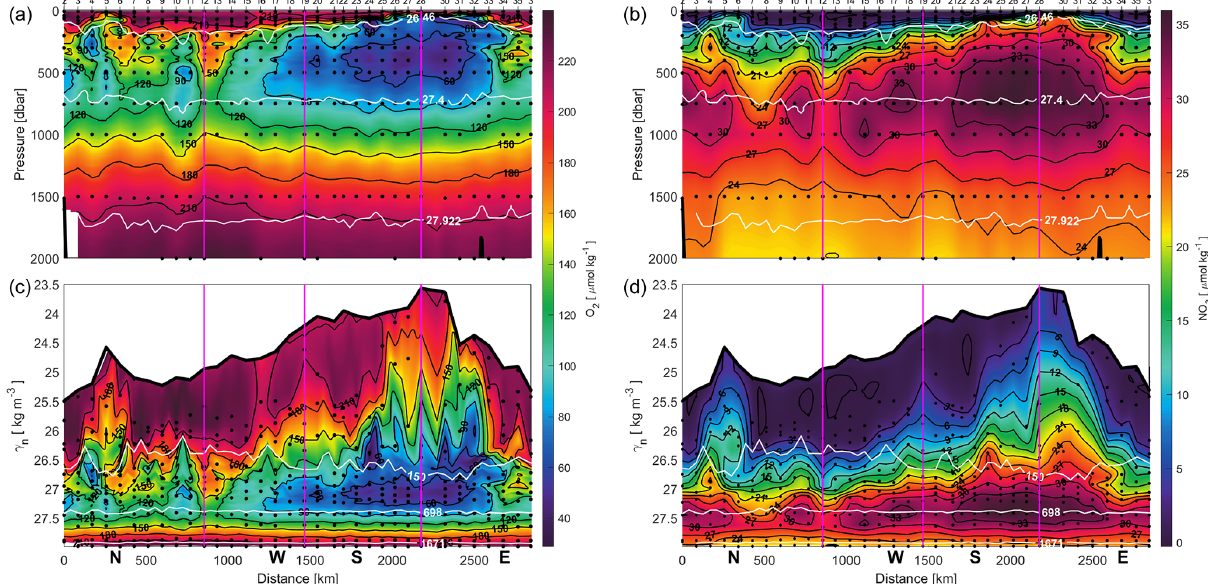
Figure 6. Sections of O 2 (a, c) and NO 3 (b, d) with respect to depth (upper line) and γ n (lower line) during the FLUXES-I cruise. The direction chosen for the representation is the same as in Fig. 3. The northwestern, southwestern and southeastern corners are indicated by three vertical pink lines at stations 12, 19 and 28, respectively. In depth sections, the isoneutrals that delimit the surface, central, intermediate and deep water are represented by white contours. In γ n sections, the depths of 150, 698 and 1671m are also shown. The sampling points of O 2 and NO 3 used in this work are represented by black dots.